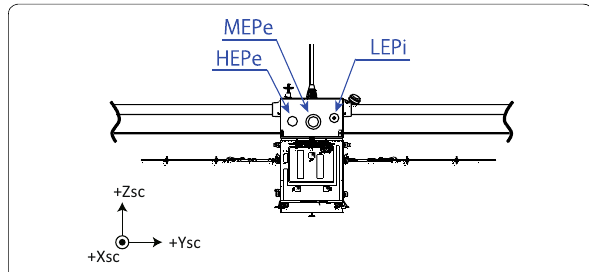
Fig. 1 Location of LEPi on ERG satellite. LEPi is mounted on the + X